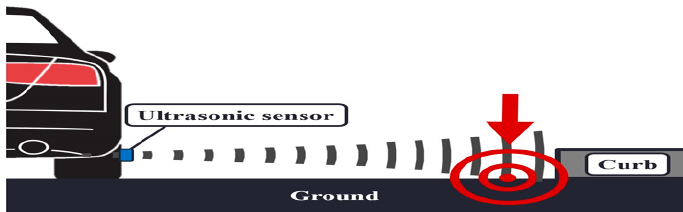
Figure 8. Curb detection using ultrasonic sensors [40].